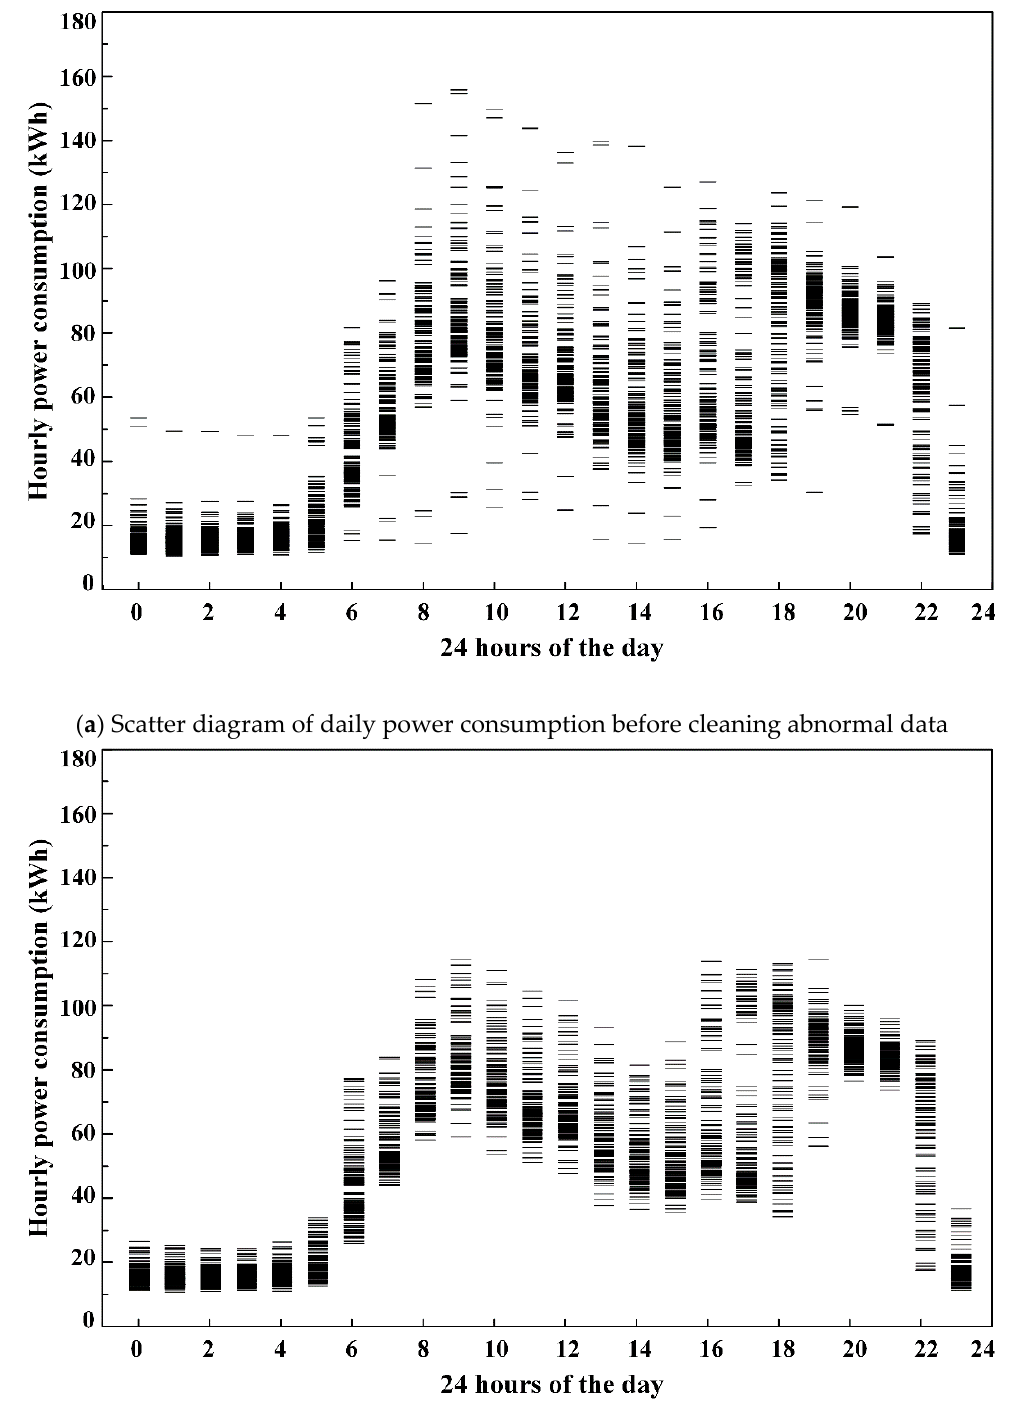
Figure 7. Scatter diagram of hourly electricity consumption of lighting sockets in Building A.